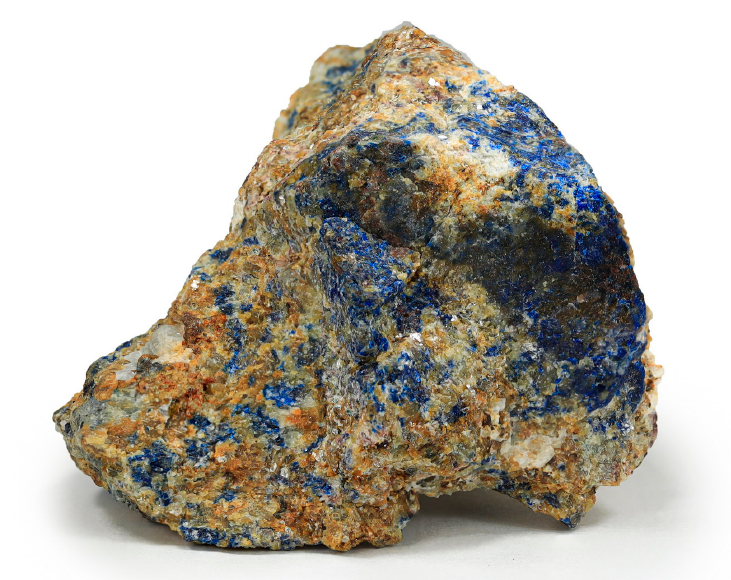
Figure 1. Bright blue CO 2 -rich, SO 4 -bearing lazurite with orange diopside in metasomatic rock. Sample 6. Field width: 9 cm. Photographer: Anastasia D. Kasatkina.